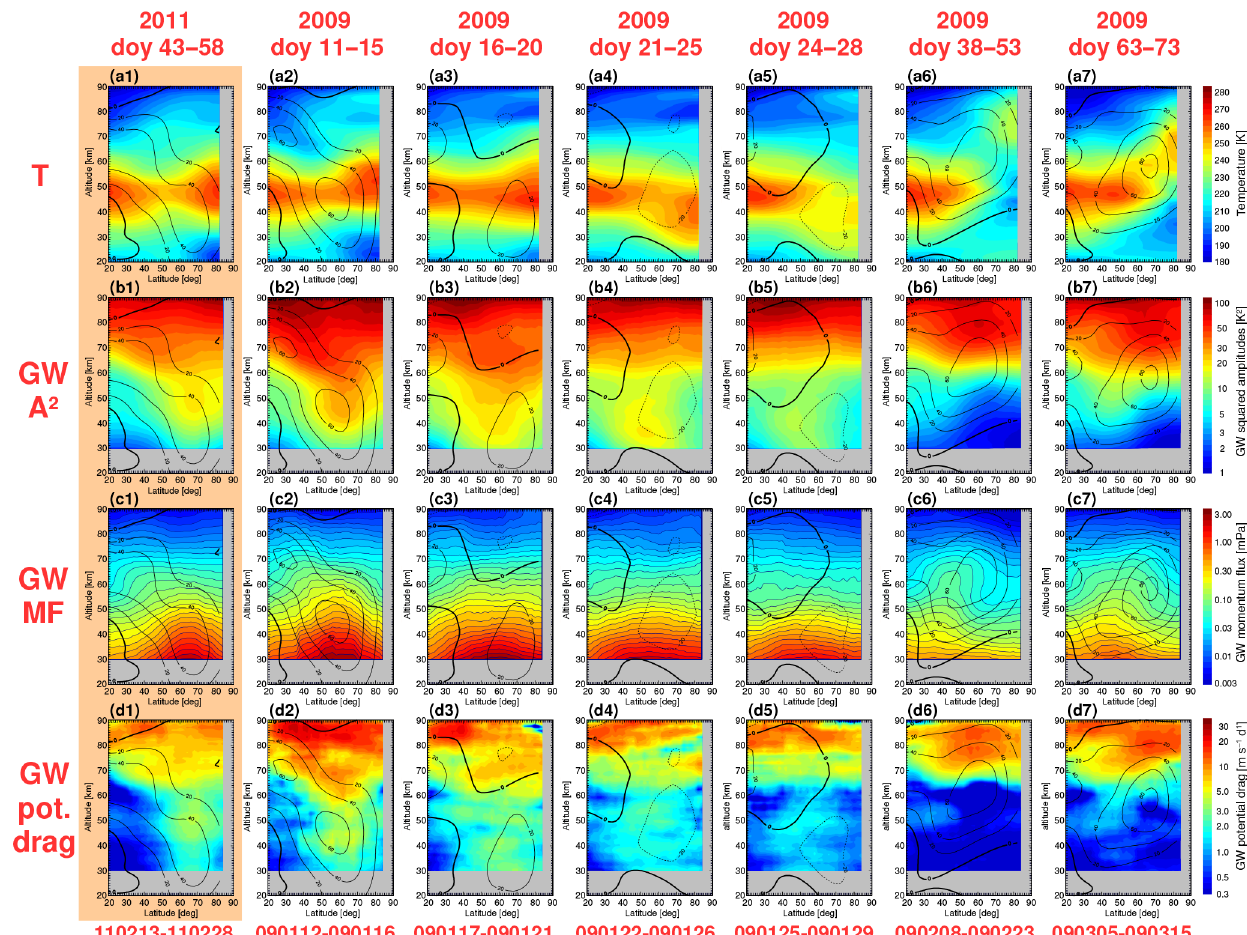
Figure 8. Zonal average cross-sections of MLS temperatures (upper), SABER gravity wave squared amplitudes in K 2 (second row), mo- mentum fluxes in mPa (third row), and potential drag in ms − 1 day − 1 (lower) for the latitudes 20–90 ◦ N during different phases of the strong major SSW in winter 2008/2009. For comparison, the left column shows an unperturbed vortex situation during February 2011. For the lower three rows logarithmic color scales are used. Overplotted contour lines indicate the zonal average of MLS geostrophic zonal winds, averaged over the respective time periods shown. Contour interval is 20ms − 1 . Dashed contour lines indicate westward